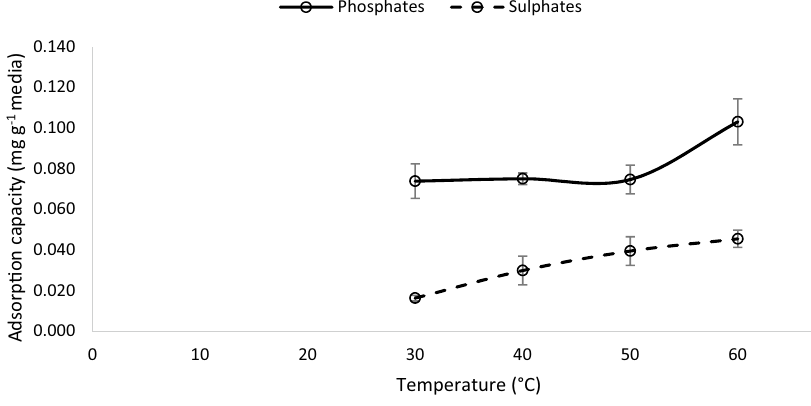
Fig. 9 Effect of temperature on PO 43− P and SO 42− adsorption by copper smelter